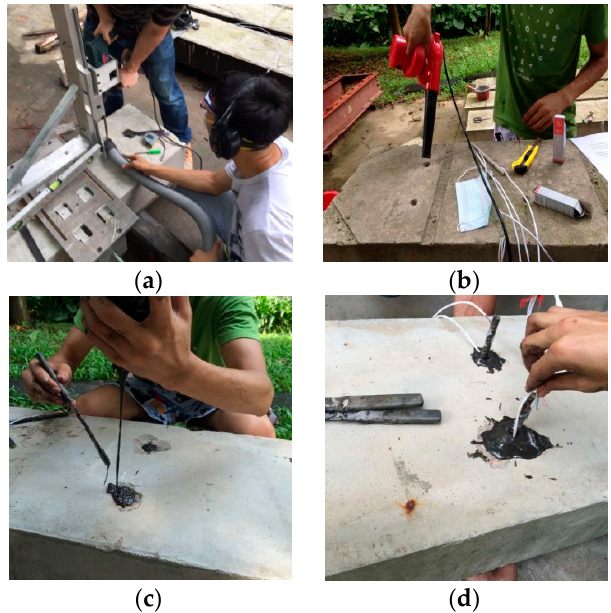
Figure 1. Deep embedment strengthening process: ( a ) Drill the hole; ( b ) Clean the hole; ( c ) Pour the epoxy resin into the slab; ( d ) Embed fibre reinforced polymer (FRP) rod into slab.